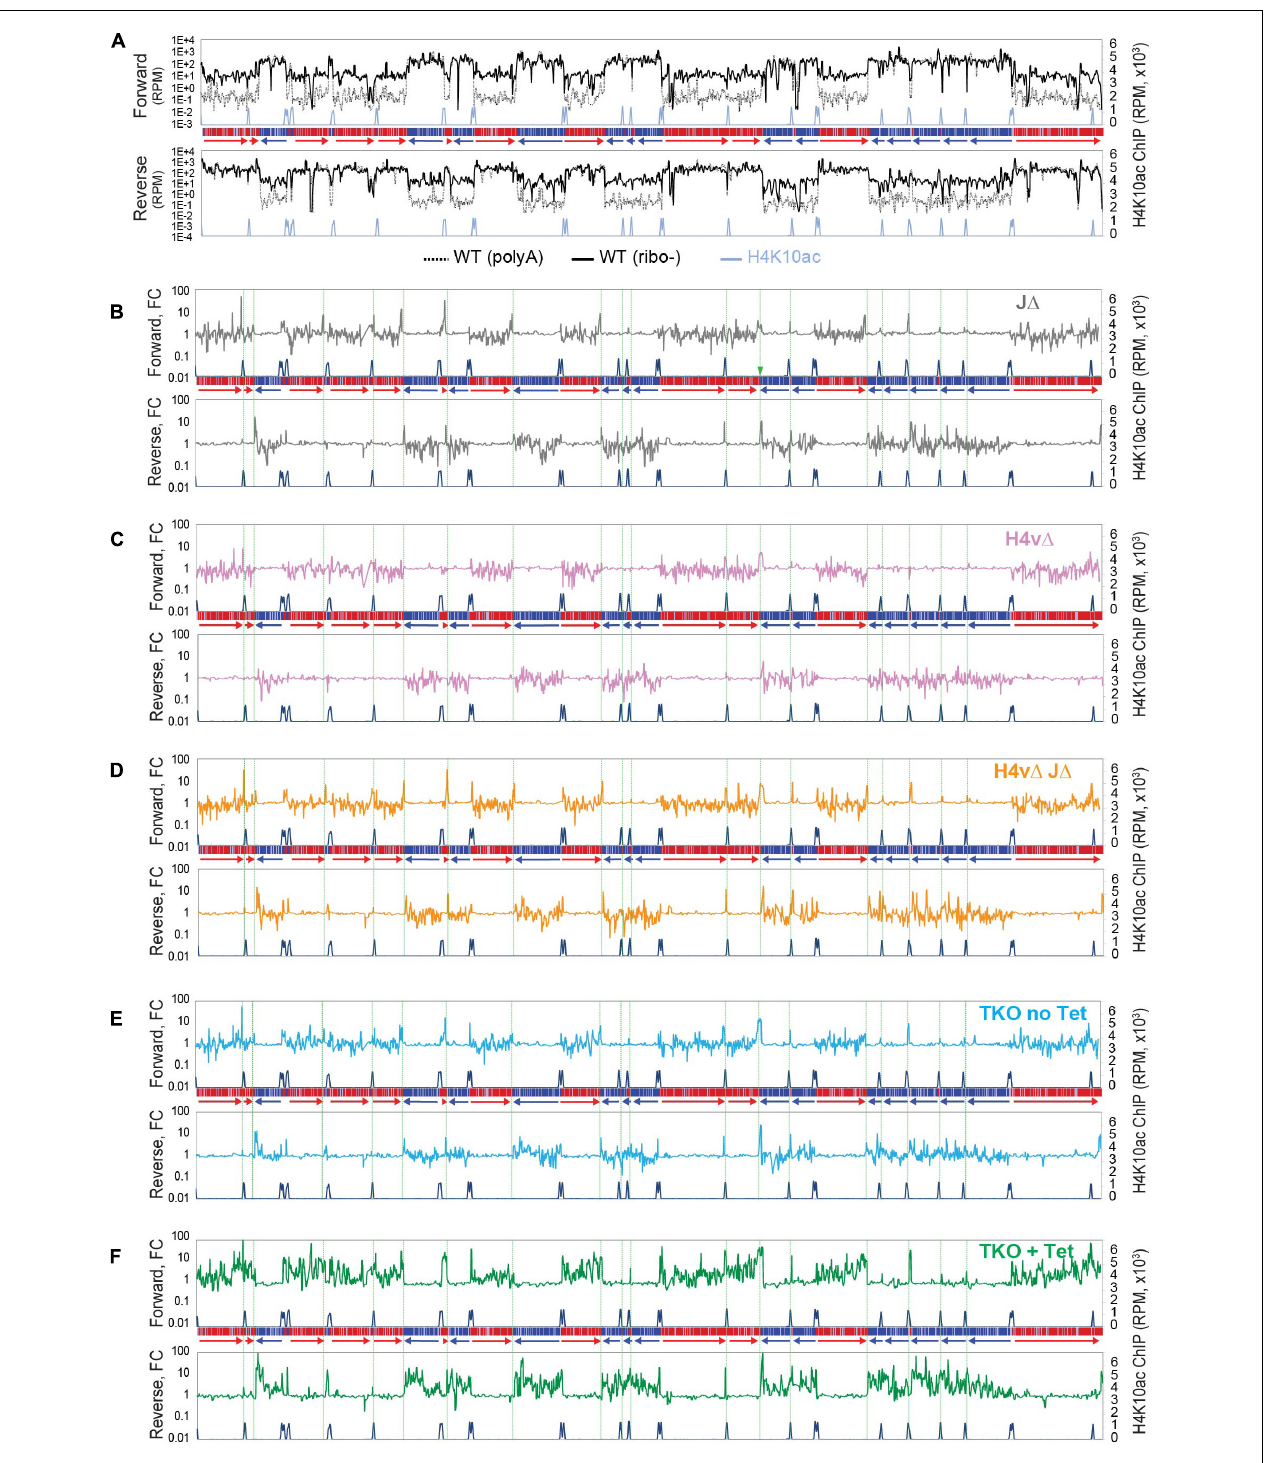
FIGURE 3 | Transcription termination site (TTS) chromatin marks affect levels of polyA-selected antisense transcripts. Global transcription was examined by polyA-selected stranded RNA-seq and mapped to the Lister 427 genome. (A) Forward and reverse reads were analyzed separately with sliding windows (5-kb bin, 1-kb step). RPM values from WT RNA-seq prepared by polyA selection (dotted black line) were compared with those from WT rRNA-depleted RNA-seq (solid black line). RPM values were plotted for all chromosomes. Chromosome 10 is shown as an example. A diagram of chromosome 10 is depicted in the middle of forward and reverse plots. (B–F) Fold changes between wild-type and each KO mutant are plotted. The shown chromosome 10 are as follows: J (cid:49) (B) , H4v (cid:49) (C) , H4v (cid:49) J (cid:49) (D) , TKO without Tet (E) , and TKO with Tet (F) . Green dotted lines indicate locations of TTSs.